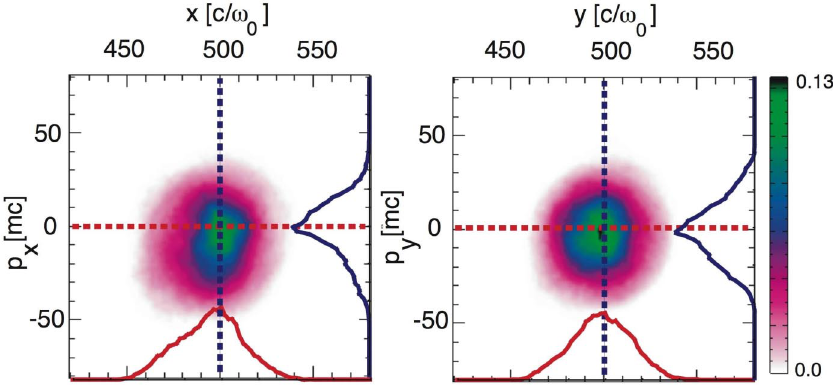
q (cid:1)(cid:1)(cid:1)(cid:1)(cid:1)(cid:1)(cid:1)(cid:1)(cid:1)(cid:1)(cid:1)(cid:1)(cid:1)(cid:1)(cid:1)(cid:1)(cid:1)(cid:1)(cid:1)(cid:1)(cid:1)(cid:1)(cid:1)(cid:1)(cid:1)(cid:1)(cid:1)(cid:1)(cid:1)(cid:1)(cid:1)(cid:1)(cid:1)(cid:1)(cid:1)(cid:1)(cid:1)(cid:1)(cid:1)(cid:1)(cid:1)(cid:1)(cid:1)(cid:1)(cid:1)(cid:1)(cid:1)(cid:1)(cid:1)(cid:1)(cid:1)(cid:1) (cid:10) (cid:3) (cid:5) h (cid:1) p 2 ih (cid:1) x 2 i (cid:2) h (cid:1) p i 2 (where (cid:1) p is normalized as indicated by the figure (cid:1) x N i i i i i i x ) and is the approximate area in phase space p . For the panels above which correspond to the first i i i (cid:10) ’ 35 (cid:5) mm rad and (cid:9) " (cid:10) ’ 29 (cid:5) mm rad . An upper limit for the emittance can be found by N x N y